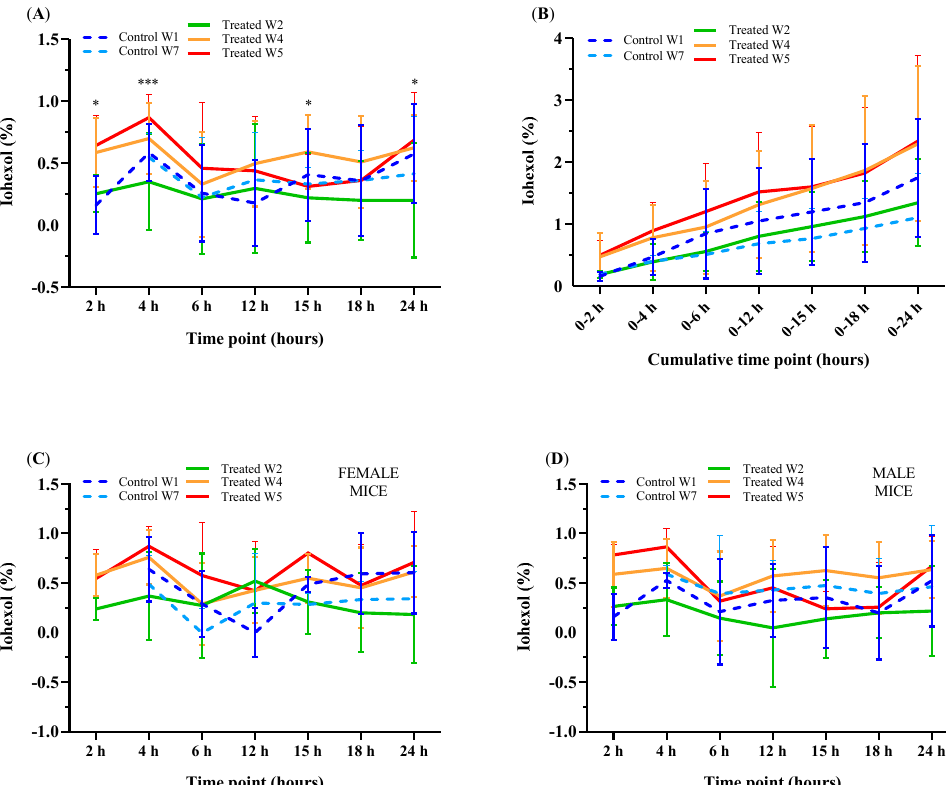
Figure 4. Urinary excretion of iohexol (%) in control and treated ( A ) female ( C ) and male ( D ) mice at seven separate urine collection time points or ( B ) at seven cumulative time points (after 2, 4, 6, 12, 15, 18 and 24 h) over 24 h after oral administration of iohexol. Data are shown on a base-10 log scale (Log10 (1 + x)) and expressed as means ± SD. * p < 0.05, *** p < 0.001. Table 1. Urinary excretion of iohexol (%) in control and treated mice measured seven times over a 24 h period after iohexol oral administration.